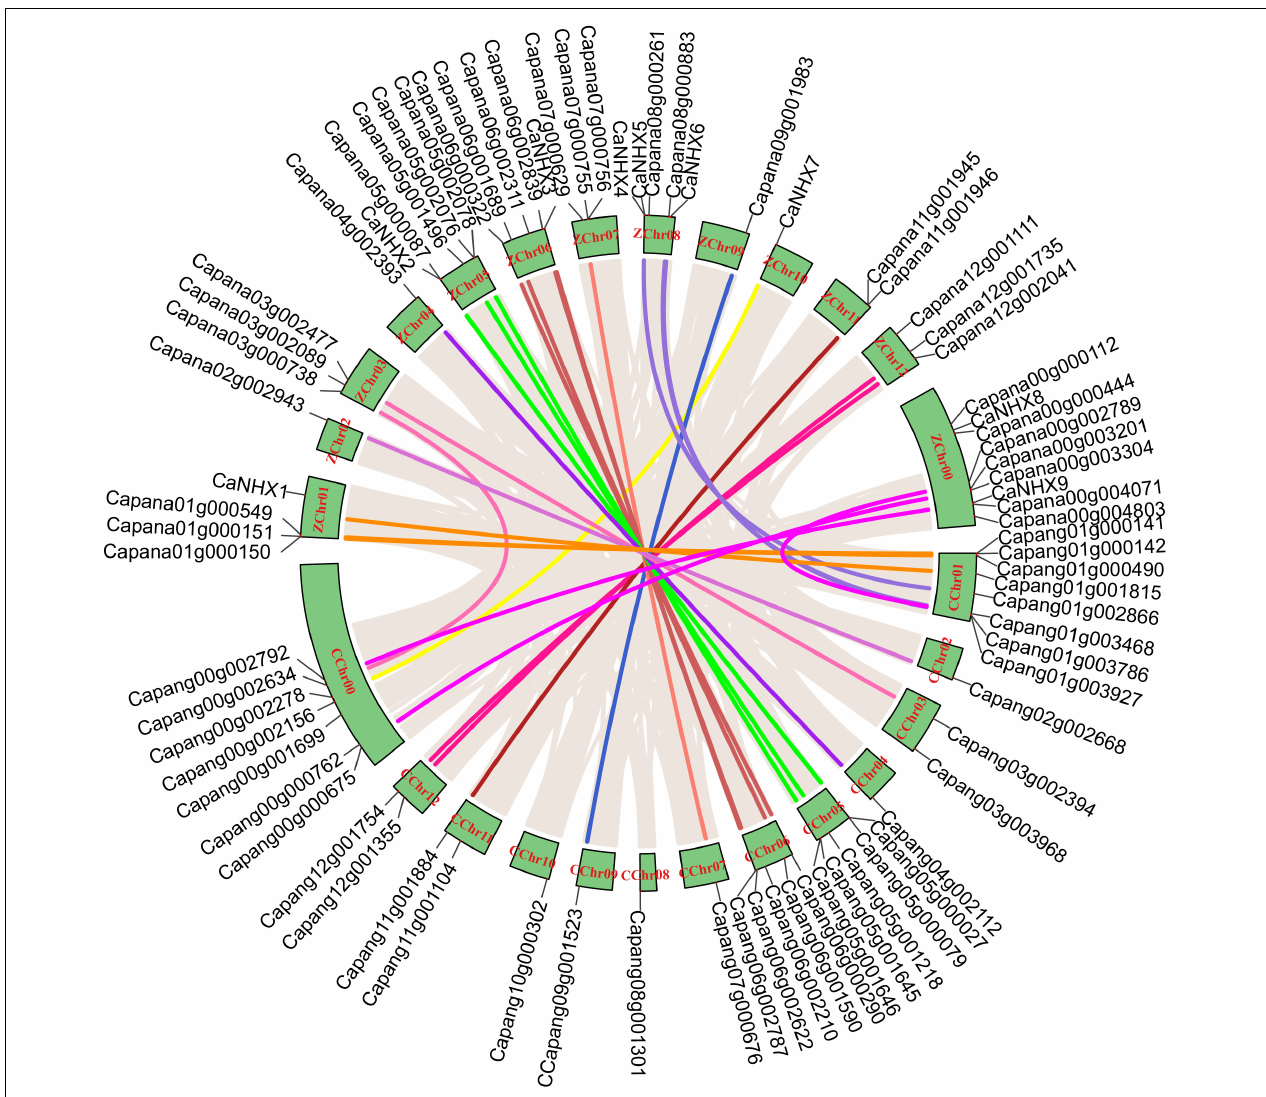
FIGURE 4 | Chromosome location and collinearity analysis of CaNHX genes in pepper.